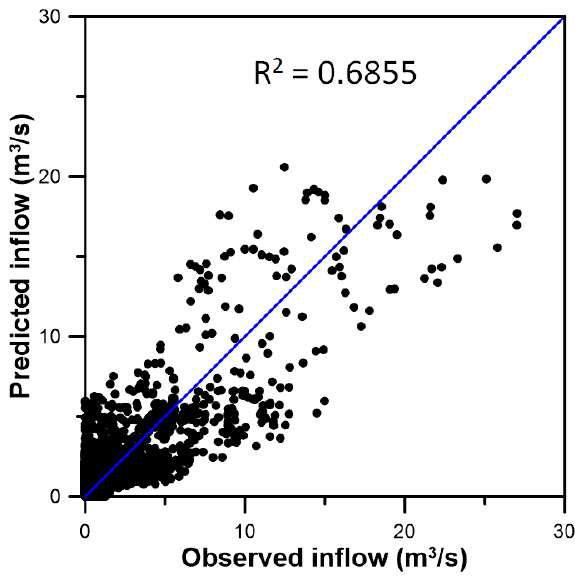
Figure 9. Comparison of R 2 for observed and predicted inflows when using Ftrl+HS.